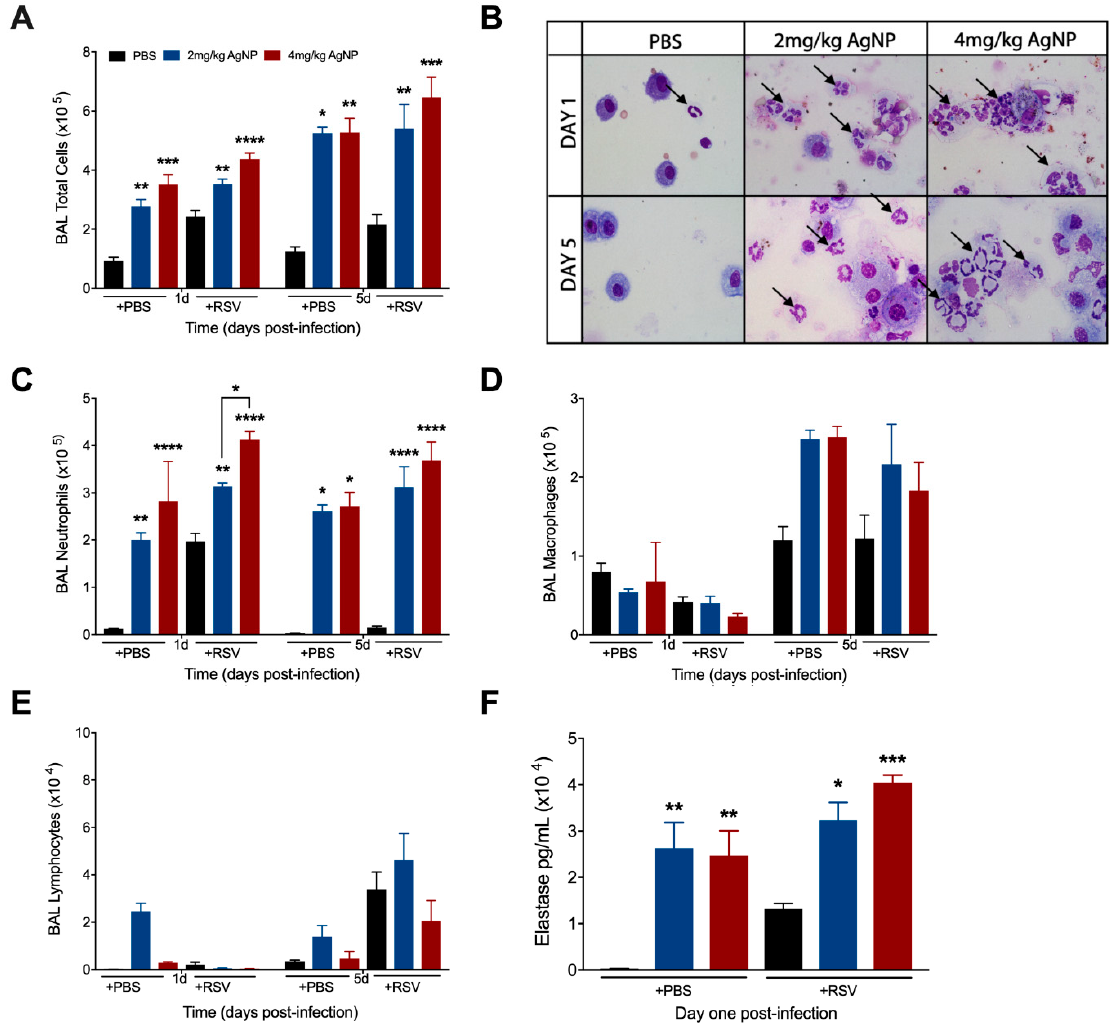
Figure 4. AgNPs increase recruitment and activation of neutrophils to the lung, regardless of infection status. Mice were inoculated with PBS, AgNP-PBS (2 mg / kg or 4 mg / kg), RSV (5 × 10 6 PFU) or AgNP-RSV. At days one and five p.i., BALF was collected from all groups and used to obtain ( A ) total cell counts, as well as di ff erential cell counts consisting of ( C ) neutrophils, ( D ) macrophages, and ( E ) lymphocytes. ( B ) BALF samples collected at days one and five p.i. from PBS untreated and AgNP-PBS mice were spun on glass slides, stained with H&E, and observed under a light microscope at 40 × magnification. The black arrows indicate neutrophils. ( F ) Neutrophil elastase concentrations were measured by ELISA using BALF collected at day one p.i. Data are expressed as mean ± SEM (n ≥ 6 mice) and is representative of three independent experiments. Significant results as compared to the respective control are marked with asterisks, and additional comparisons between groups are indicated with brackets (* for p ≤ 0.05, ** for p ≤ 0.01, *** for p ≤ 0.001, **** for p ≤ 0.0001).